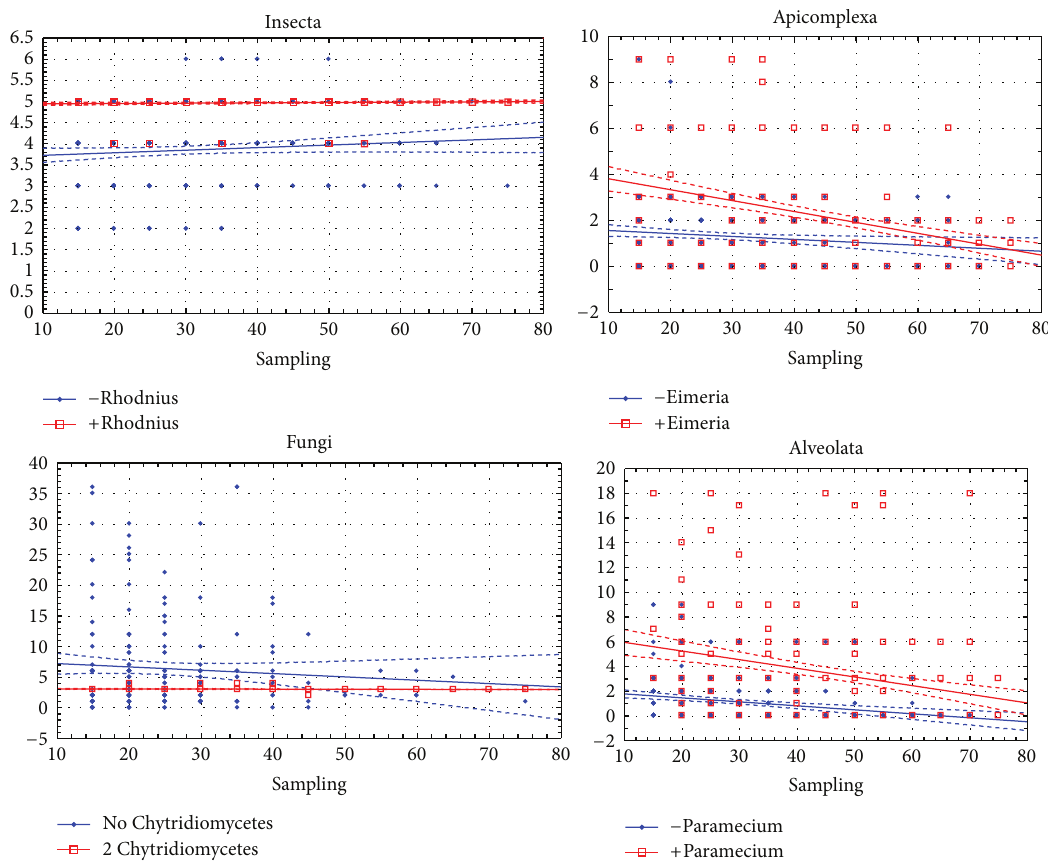
Figure 5: Effects of critical species sampling on the behavior of the NYK algorithm. Horizontal axis: number of species in the sampling. Vertical axis: inferred intron density at the node